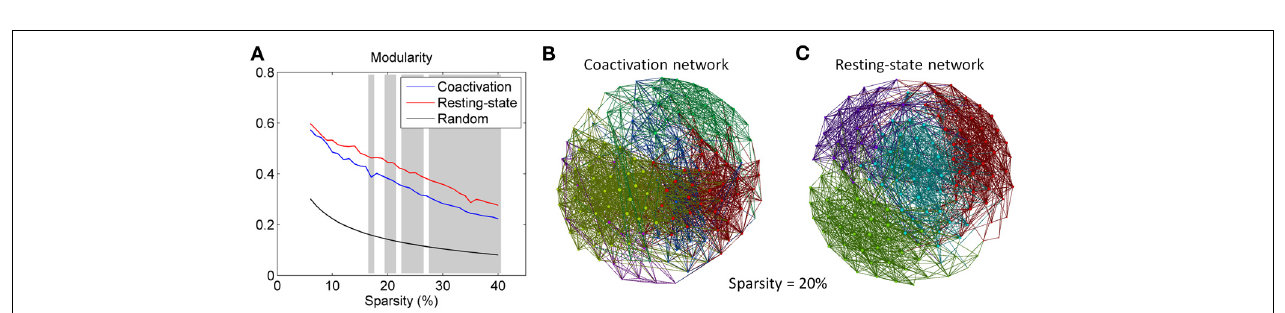
FIGURE 3 | (A) Modularity for the coactivation, resting-state, and random networks as a function of connectivity sparsity. The shading areas represent significant differences between the coactivation and resting-state networks at p < 0 . 001 based on 1000